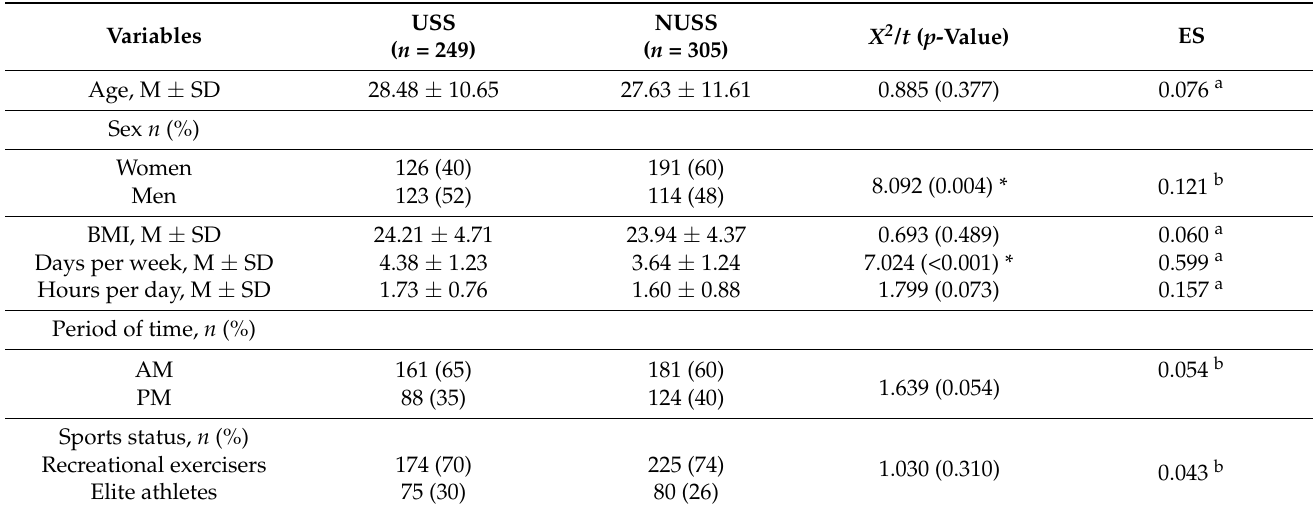
Table 2. Differences between USS and NUSS in demographic and sports variables.